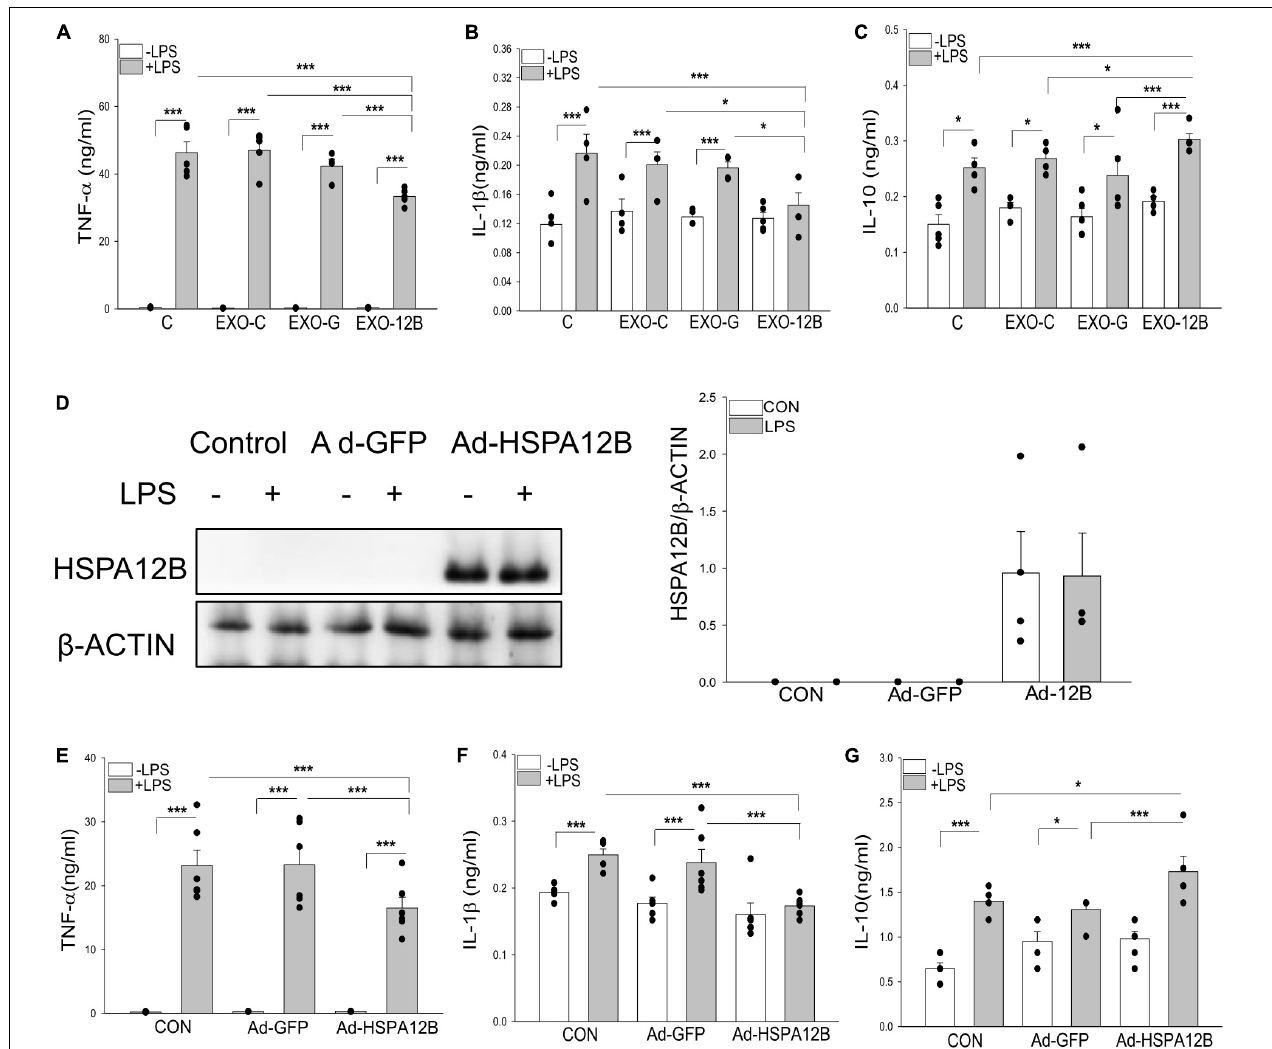
FIGURE 6 | Endothelial exosomes altered macrophage response to LPS stimulation. Exosomes were isolated from HEVECs that were transfected with Ad-HSPA12B or Ad-GFP followed by LPS stimulation for 24 h. Macrophages (RAW 264.7) were incubated with the isolated exosomes before LPS (1 µ g/ml) stimulation for 24 h. The medium were collected for measurement of TNF- α (A) , IL-1 β (B), and IL-10 (C) with ELISA. n = 4 independent experiments/group. (D) Macrophages (Raw264.7) were transfected with Ad-HSPA12B or Ad-GFP for 6 h by K2 transfection system then changed with fresh medium overnight before the cells were stimulated with LPS (1 µ g/ml) for 1 h. (D) Western blot analysis of HSPA12B levels in macrophages. The (E,F) Macrophages (Raw 264.7) were transfected with Ad-HSPA12B or Ad-GFP for 6 h by K2 transfection system then changed with fresh medium overnight before the cells were stimulated with LPS (1 µ g/ml) for 24 h. Cultured medium was collected for the measurement of TNF- α (E) , IL-1 β (F), and increased IL-10 (G) with ELISA. n = 3 ∼ 5 independent experiments/group. * P < 0.05 and *** P < 0.001 compared with indicated